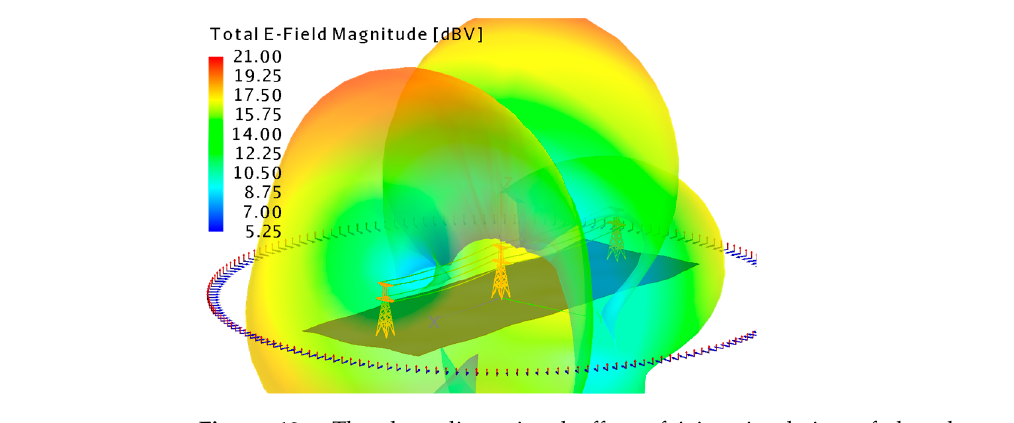
Table 4. Factors and levels of co-simulation.